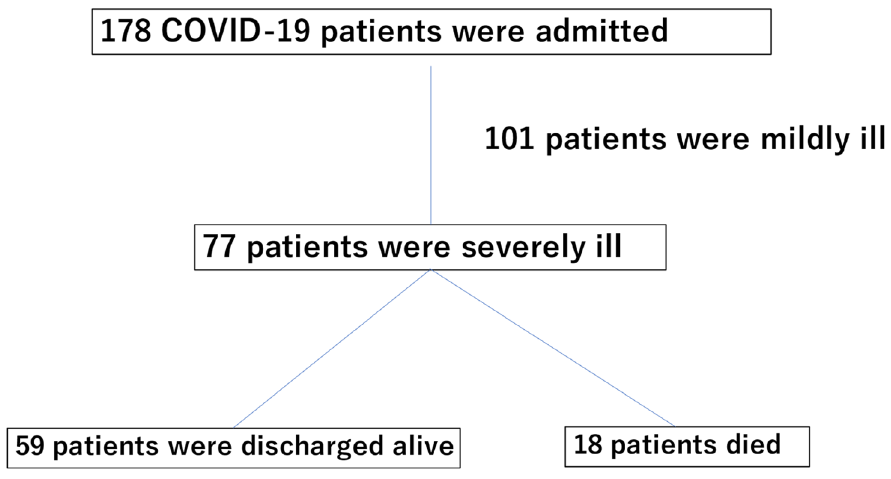
Figure 1. Flow chart of patient